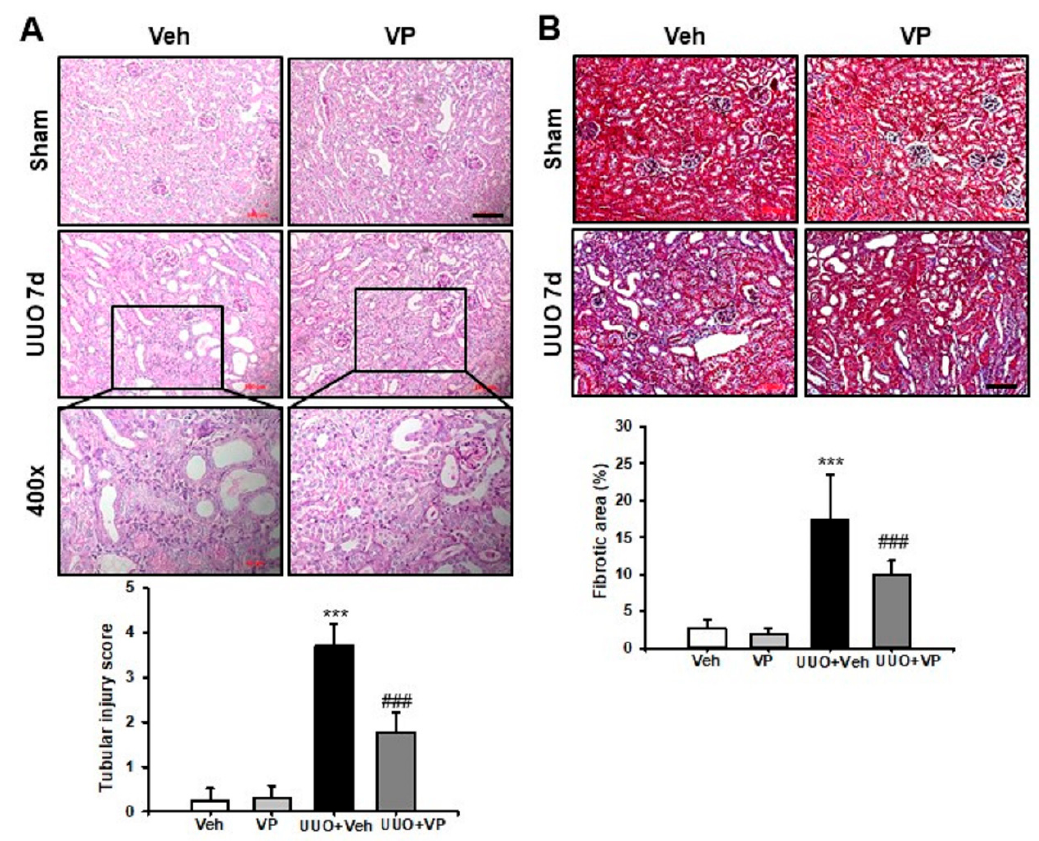
Figure 1. Effect of verteporfin on UUO-induced renal tubular injury and fibrosis. Representative PAS and MTC stains from the kidneys of sham- and UUO-operated mice treated with vehicle (Veh) or verteporfin (VP). Scale bar = 100 µm. Inlet shows a higher magnification view (400×) of UUO 7 d with Veh or VP treatment. The bar graphs show the semi-quantitative scoring of ( A ) tubular injury stained by PAS and ( B ) the area fraction (%) of tubulointerstitial fibrosis stained by MTC from ten randomly chosen, non-overlapping fields ( n = 10) at a magnification of 200× ( n = 15/group). Data are expressed as the mean ± SD. *** p < 0.001 versus Veh or VP; ### p < 0.001 versus UUO. Veh, vehicle; VP, verteporfin; Sham, sham-operated mice; UUO, unilateral ureteral obstruction operated mice.